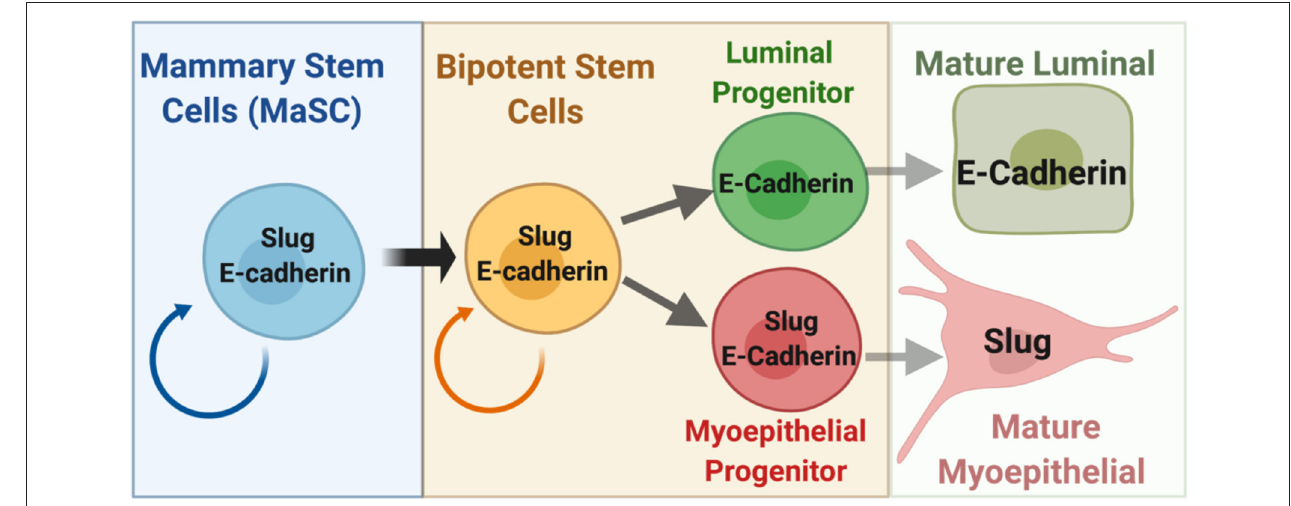
FIGURE 1 | Schematic of the mammary epithelial stem cell hierarchy depicting the known and proposed relationships of Slug and E-cadherin (see text for details). Relative differences in expression levels between cells can be assumed but are not depicted. Figure was created with